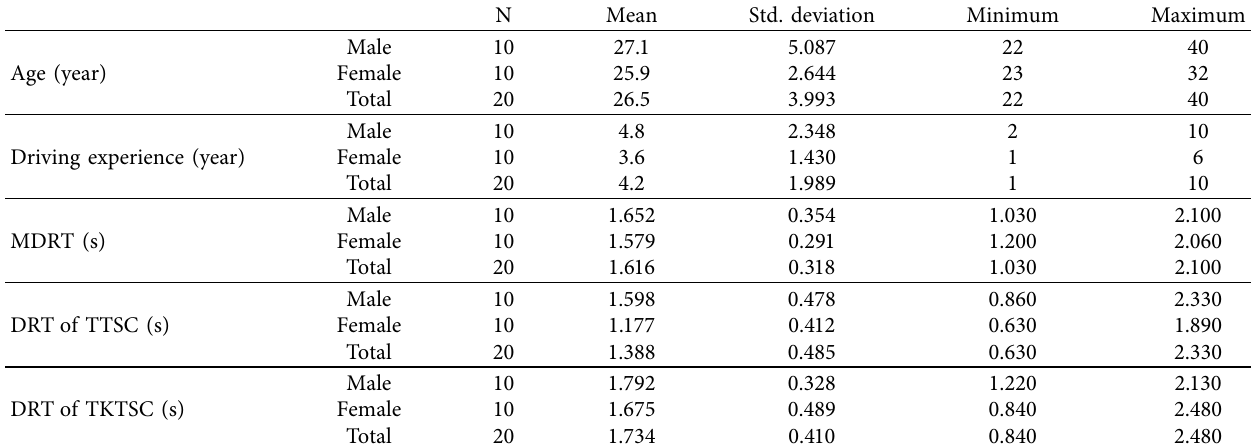
Table 4: The statistical description of